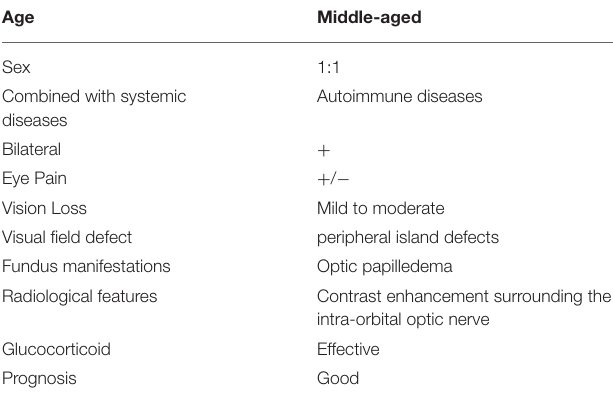
TABLE 5 | Clinical and radiological features of optic